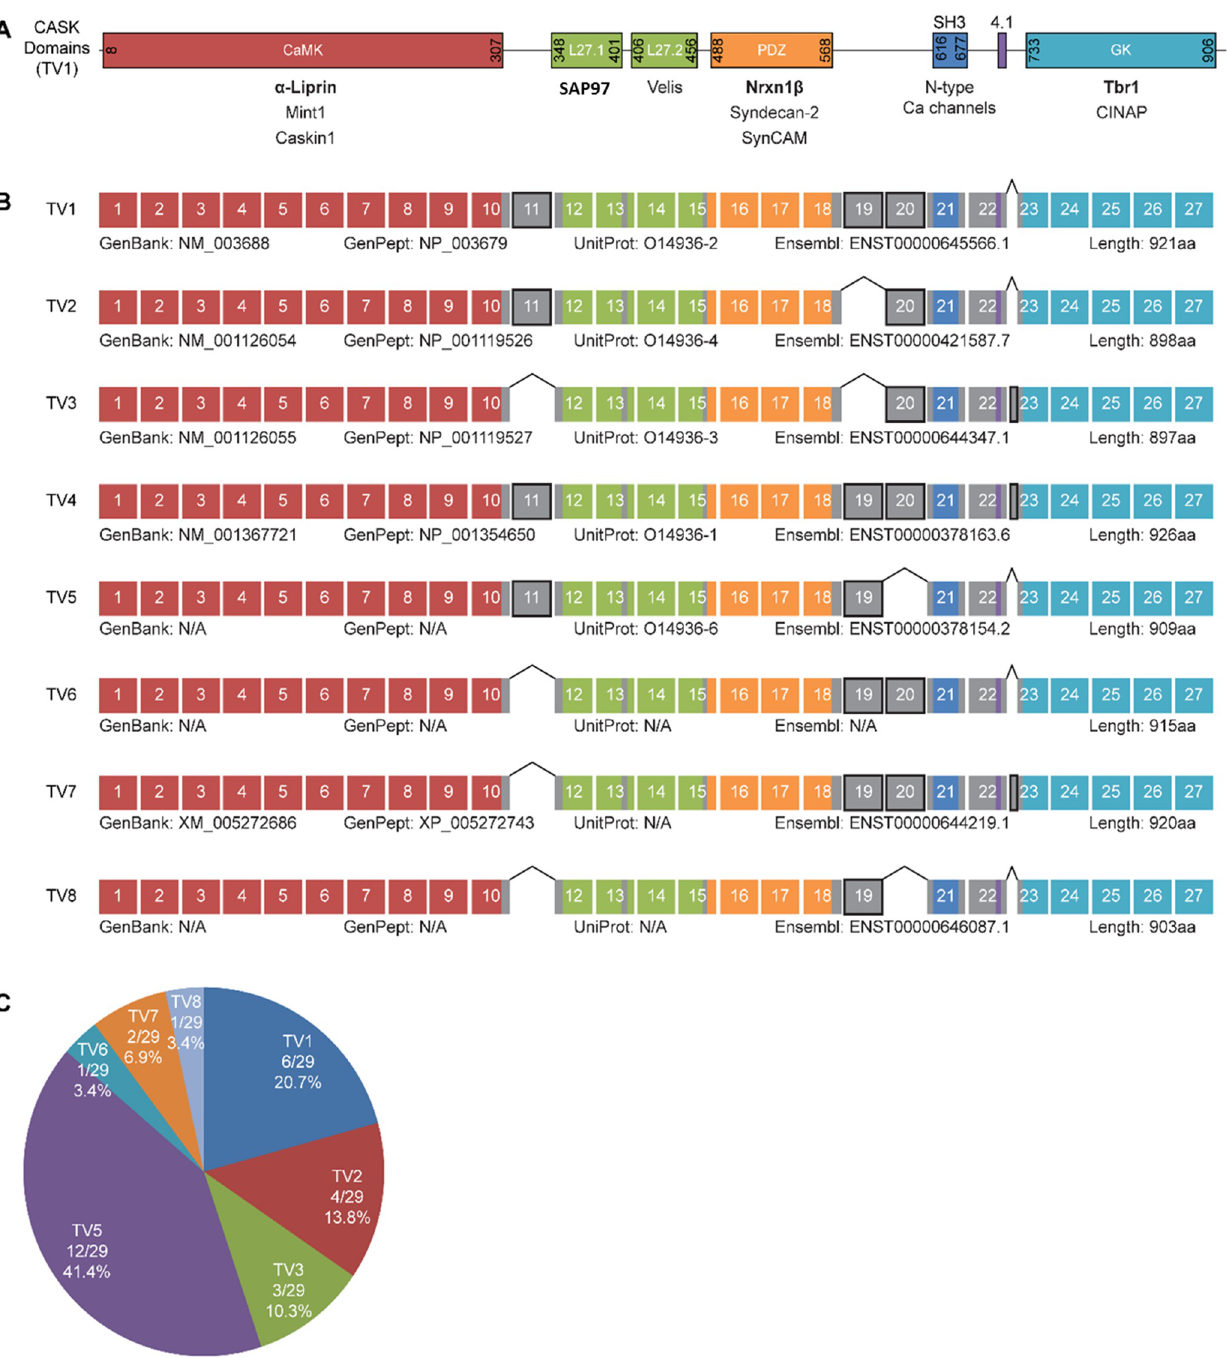
PLOS ONE | https://doi.org/10.1371/journal.pone.0253223 June 16, 2021 4 /